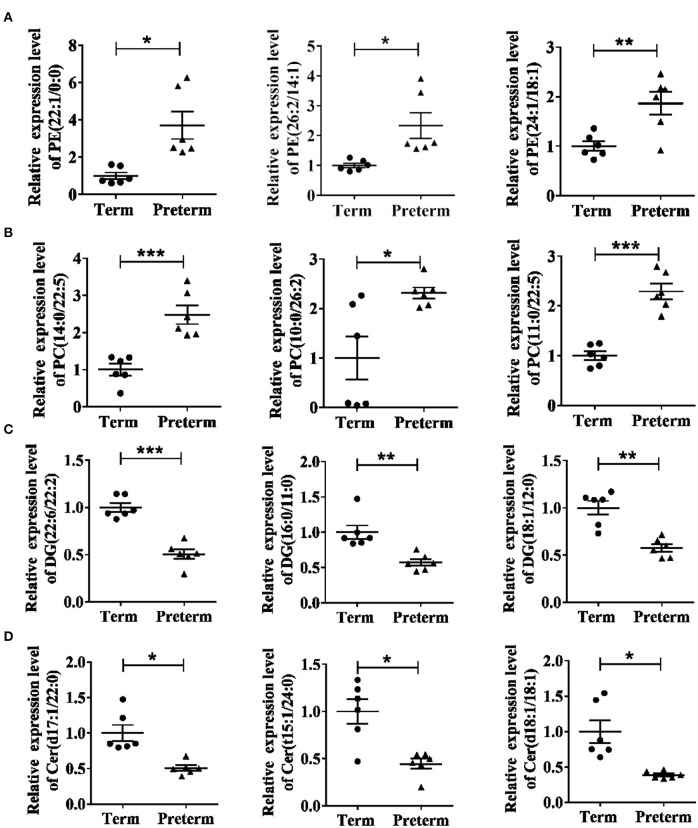
Twelve significantly different lipids in the term and preterm groups. (A) Top three significantly upregulated PEs in preterm group. (B) Top three significantly upregulated PCs in preterm group. (C) Top three significantly downregulated DGs in preterm group. (D) Top three significantly downregulated Cers in preterm group. PE, phosphatidylethanolamine; PC, phosphatidylcholine; DG, diacylglycerol; Cer, ceramide. *P < 0.05; **P < 0.01; ***P < 0.001.